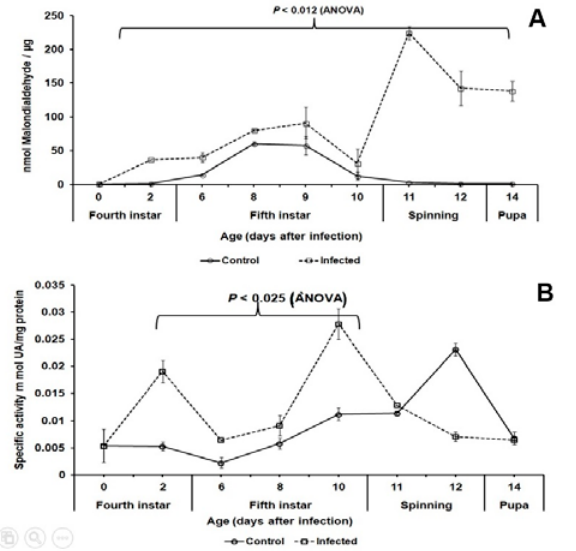
Figure 5 A-B. Lipid peroxidation in hemocytes of B. mori larva induced after infection by N. bombycis indicated by the variation in malondialdehyde which is a bye-product of lipid peroxidation (A): Lipid peroxidation was at significantly higher level from ini- tial stages of infection and at peak level from day 11 onwards. (B): Variation in ascorbate peroxidase (PRX) activity in hemocytes of B. mori larva induced after infection by N. bombycis : PRX activity was significantly higher after infection with peak activity on day 2 and 10 followed by decline from day 11